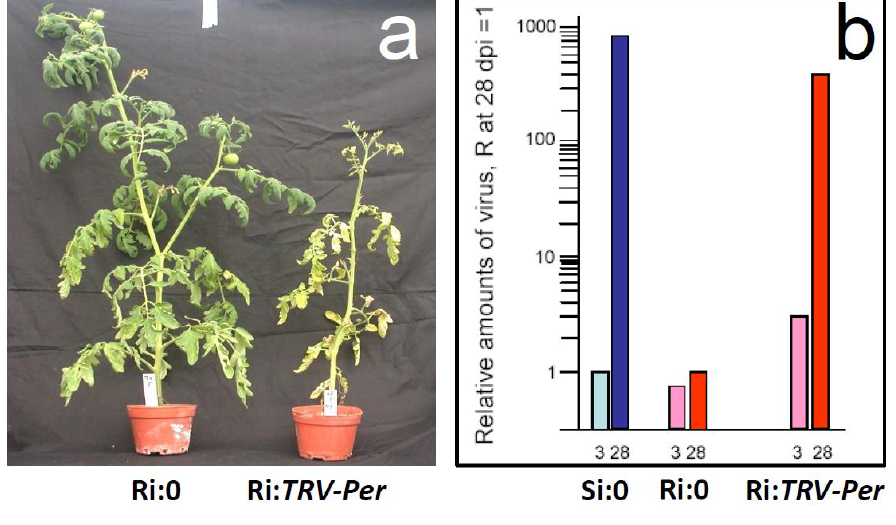
Figure 5. Collapse of resistance in infected R plants where the Permease I gene has been silenced. a : R tomato plants 8 weeks after TYLCV inoculation; Ri:0, not silenced; Ri: TRV-Per , silenced. Note that Ri:0 do not present symptoms and yield fruits, in comparison Ri: TRV-Per are symptomatic and present inhibited growth. b : Relative amounts of virus (measured by qPCR) in infected tomato plants 3 and 28 days after inoculation; Si:0 is S plants, Ri:0 is R plants and Ri: TRV-Per is R plants where the Permease I gene has been silenced. The amount of virus in Ri:0 plants at 28 dpi was considered as